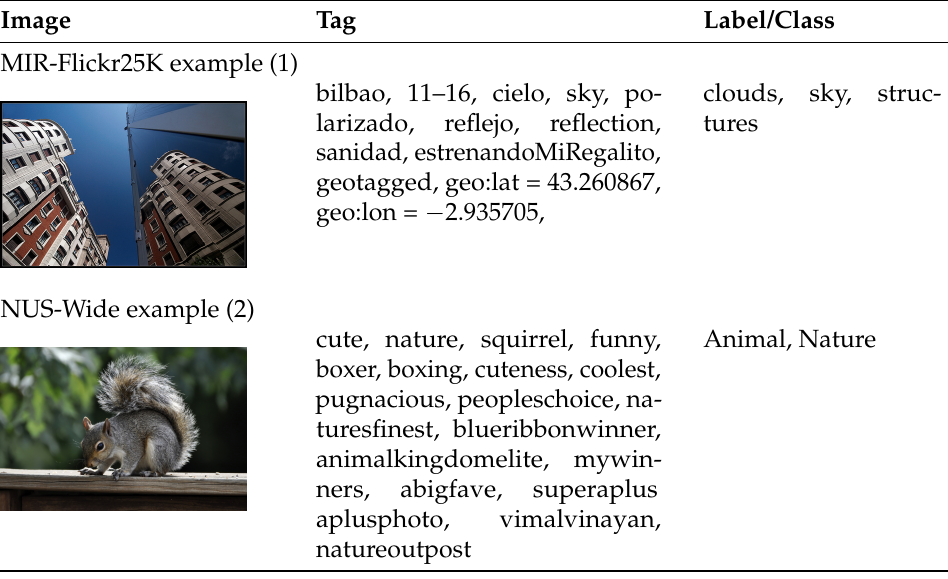
Table 2. Example of images, paired tags, and labels from the MIR-Flickr25K and NUS-WIDE